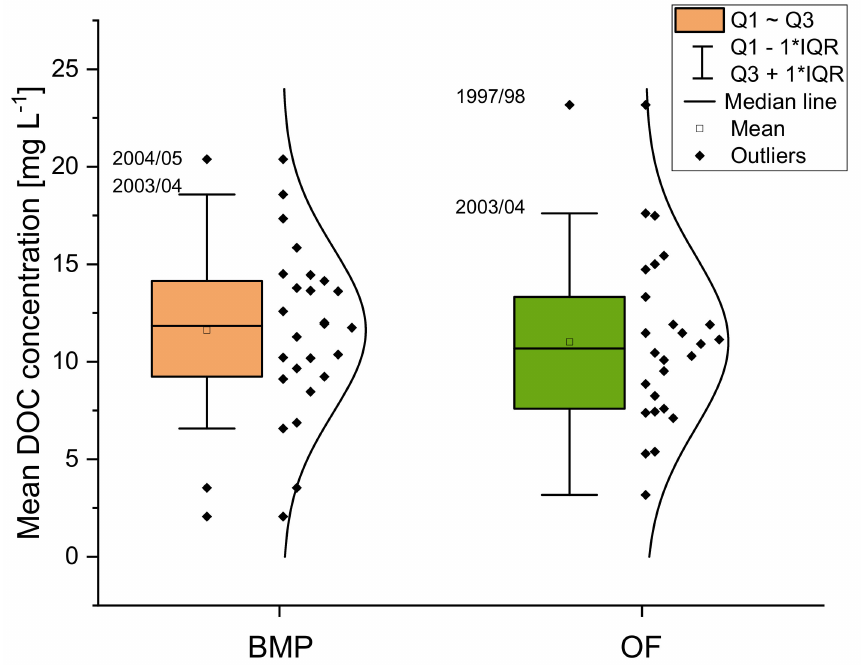
Figure 6. Box plot and frequency distribution of mean DOC concentration and identification of lysimeter years with distinct increasing of mean DOC concentration of Organic Farming (OF) and Best Management Practice (BMP) for the study period